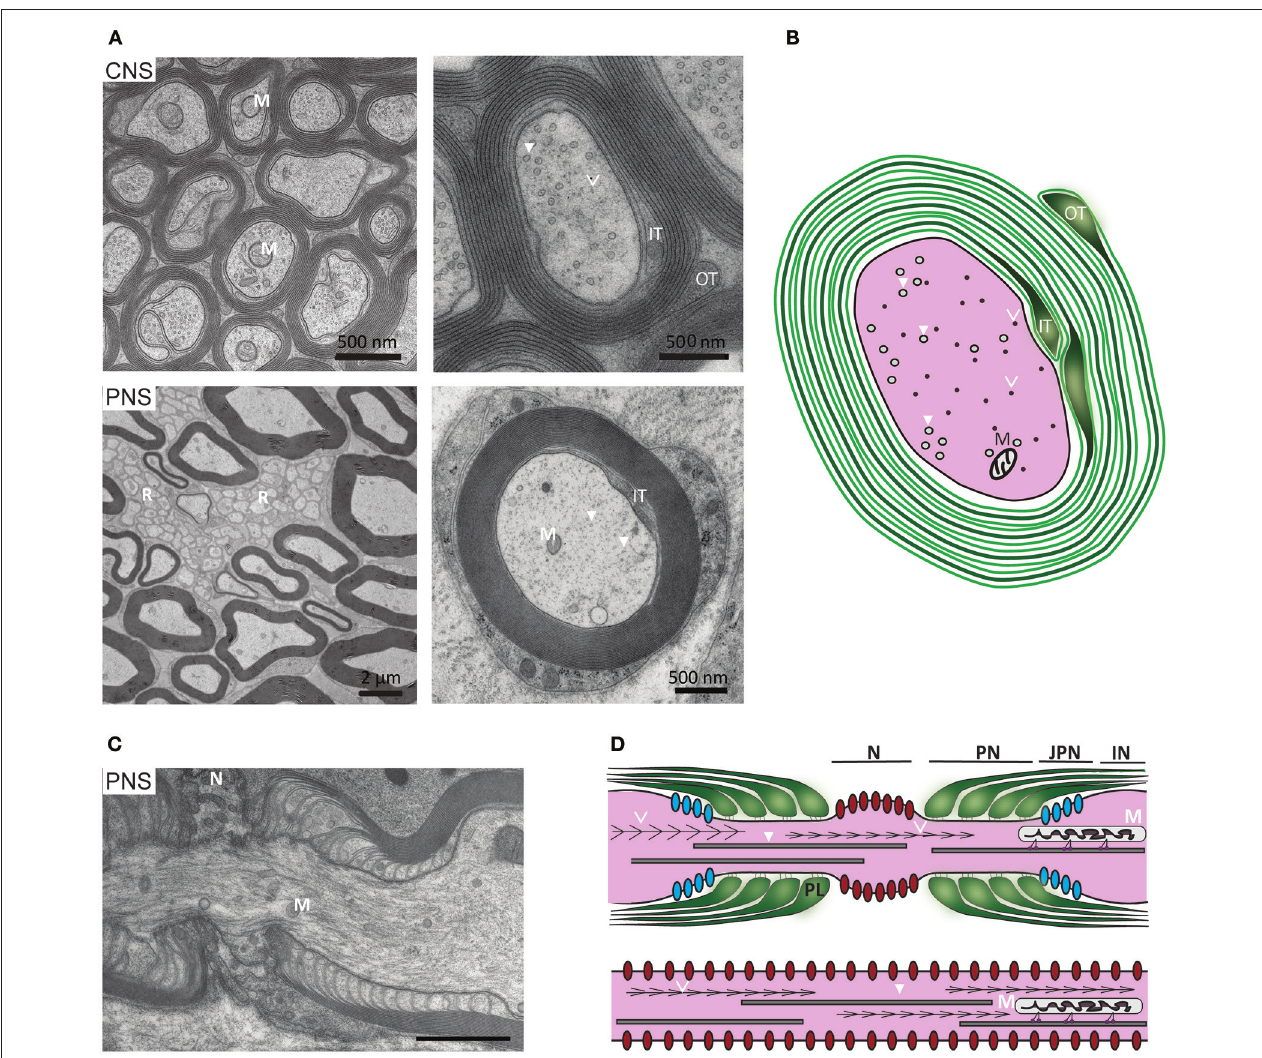
FIGURE 1 | Ultrastructure of myelinated axons in the CNS and PNS. ( A , upper) In the CNS, myelinated axons are densely packed within white matter (here: mouse optic nerve) and the myelin sheaths of neighboring fibers often directly touch. At high magnification axonal cytoskeletal elements are visible: microtubules (arrows) and neurofilaments (arrowheads). As indicated in the schematic, mitochondria are closely associated with microtubules (M, mitochondria; IT, inner tongue; OT, outer tongue). ( A , lower) In the PNS, the Schwann cell plasma membrane is covered with a basal lamina and the myelinated fibers are separated by connective tissue. Small caliber axons are not myelinated, but organized in so-called Remak bundles (R) formed by non-myelinating Schwann cells. At high magnification, mitochondria and cytoskeletal elements can be observed. (B) Schematic representation of a myelinated CNS fiber: The plasma membrane of the myelinating glial cell is depicted in green. The major dense line (depicted in grey) results from the apposition of the cytoplasmic surfaces of the plasma membrane. (C) Electron micrograph of a PNS node of Ranvier and ( D , upper) schematic representation of the elements of a node: paranodal loops of the myelin sheath (green), Nav1.6 channels (red), Kv1 channels (blue), neurofilaments (arrowheads), microtubules (open arrowheads), mitochondria (M), which are transported along microtubules. N, node; PN, paranode; JPN, juxta paranode; IN, internode. ( D , lower) Schematic representation of non-myelinated axon with uniform distribution of Nav1.6 channels along the axolemma.